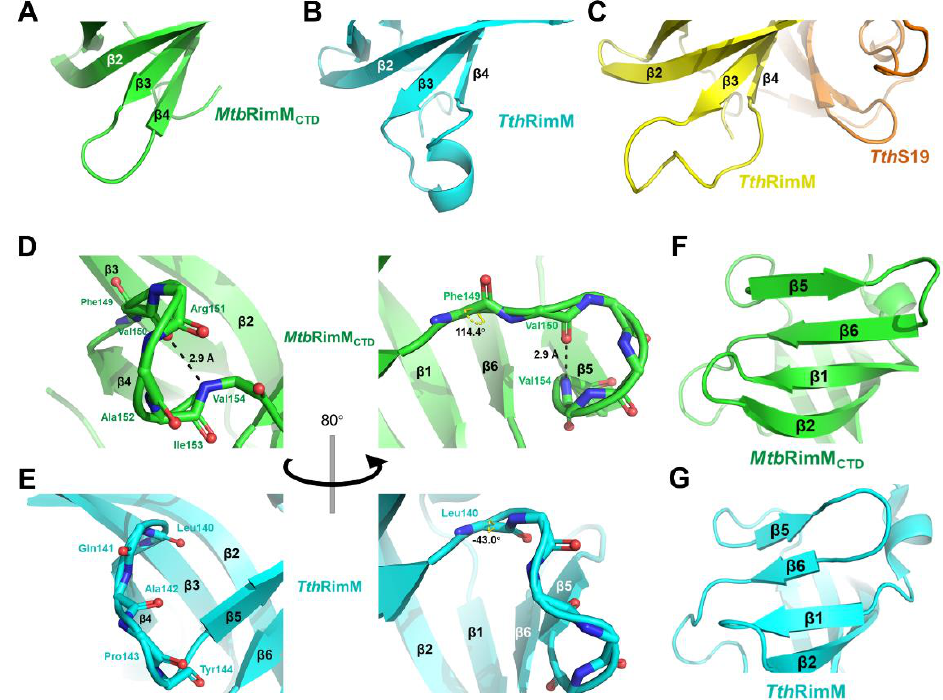
Figure 3. Structural comparison between Mtb RimM CTD and RimM from T. thermophilus HB8 ( Tth RimM) represented in cartoon. ( A – C ) β 3- β 4 loop of Mtb RimM CTD ( A ), free Tth RimM ( B ), S19-complexed Tth RimM ( C ). ( D , E ) β 4- β 5 loop of Mtb RimM CTD ( D ) and free Tth RimM ( E ). The dihedral angle ψ of F149 in ( D ) and L140 in ( E ) are identified. The length of the hydrogen bond (V154)N-H . . . O(V150) is also depicted in ( D ), where backbone oxygen or nitrogen atoms are shown as red and blue sticks, respectively. Hydrogen atoms, if applicable, are hidden. ( F , G ) β5 and β6 strands of Mtb RimM CTD ( F ) and free Tth RimM ( G ).